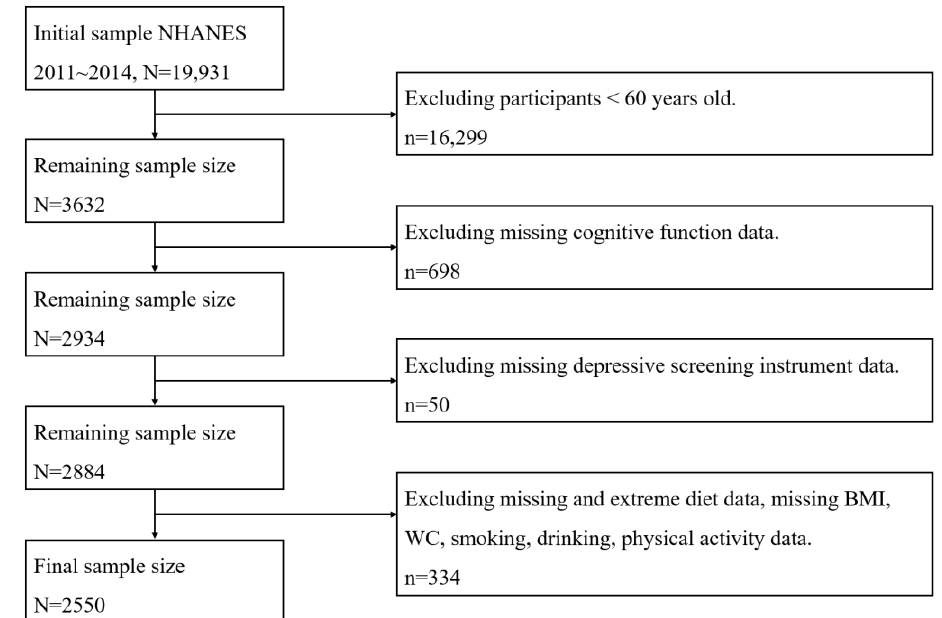
Figure 1. Flowchart for the study design and participants.